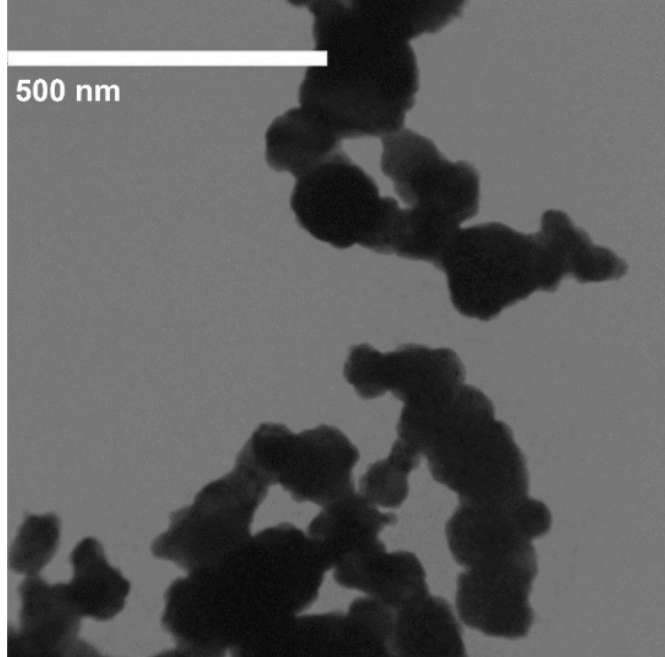
Table 2. Mechanical properties under Т = 20 ° С of 90 CrSi steel. Properties